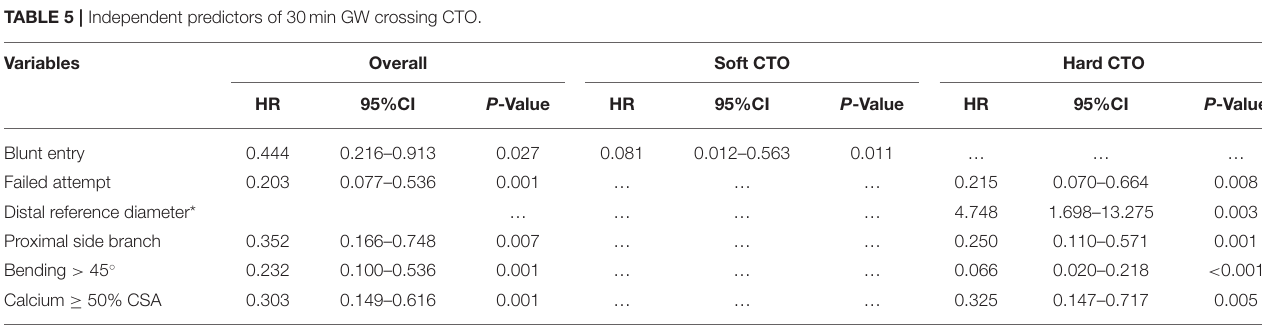
TABLE 5 | Independent predictors of 30min GW crossing CTO.